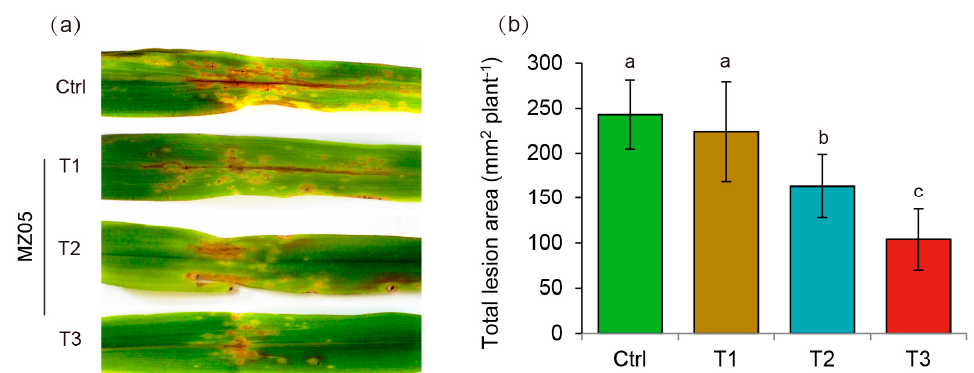
Figure 1. P. fluorescens MZ05 increased maize resistance against S. turcica . Four-week-old maize plants were treated with different doses (T1, 1 × 10 6 CFU g -1 soil; T2, 1 × 10 7 CFU g -1 soil; T3, 1 × 10 8 CFU g -1 soil) of P. fluorescens strain. After 7 days of inoculation, these plants were sprayed with a spore suspension of S. turcica at 5 × 10 4 conidia mL -1 . After 5 days of pathogen infection, disease symptoms were monitored ( a ), and total lesion area was measured on the fourth leaves from individual plants using ImageJ software ( b ). Statistical analyses for the data were performed from three independent experiments and each experiment consisted of 15 plants. Different letters indicate statistically significant differences between the control (Ctrl) and inoculated plants using one-way analysis of variance and Ducan’s tests ( p < 0.05).